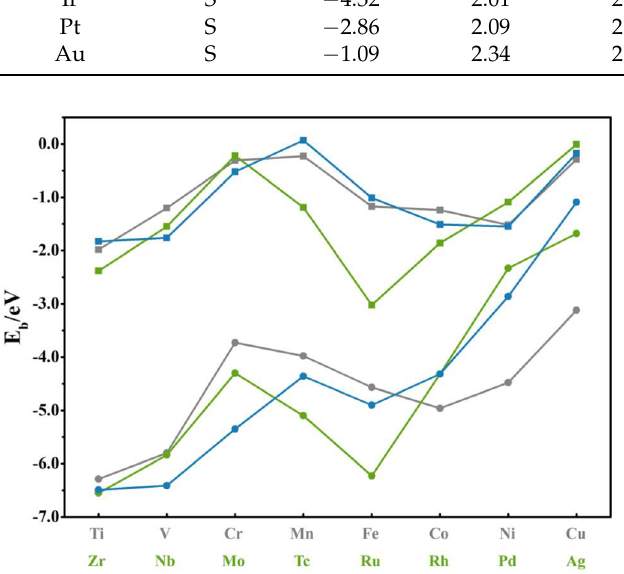
Figure 2. The binding energies of the TM 1 − G and TM 1 − SVGN 3 are shown in square and circle, re- spectively.